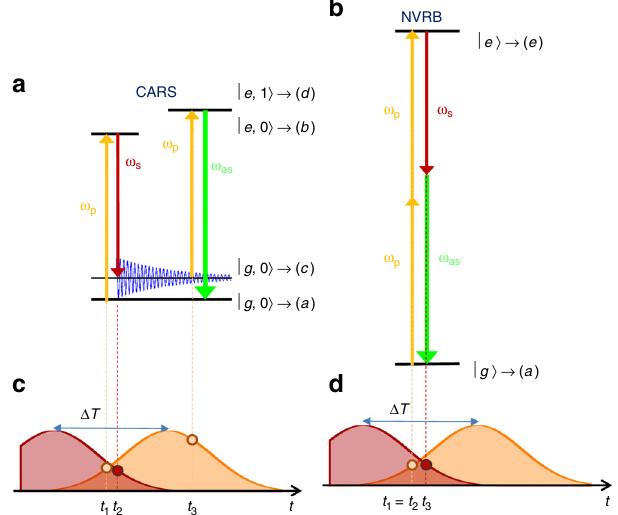
Fig. 1 Schematic of CARS and NRVB third-order nonlinear processes. Interaction with pulses ω P , ω S , results in blue-shifted ( a ) CARS and ( b ) NVRB contributions at ω as = 2 ω P − ω S . Since in CARS a vibrational coherence is stimulated by two consecutive interactions with the pump and Stokes fi elds, their frequency difference must correspond to a Raman active mode, ω P − ω S = ω v . c , d Constraints for the temporal sequence of the fi eld-matter interactions (represented by circles at the top of the pulse envelopes), for CARS and NVRB. In NVRB, the three interactions generating χ (3) happen within the few fs electronic dephasing time 20 . In CARS, the third interaction can occur over the much longer vibrational dephasing time (a few ps) 20 , within the pump pulse (PP) temporal